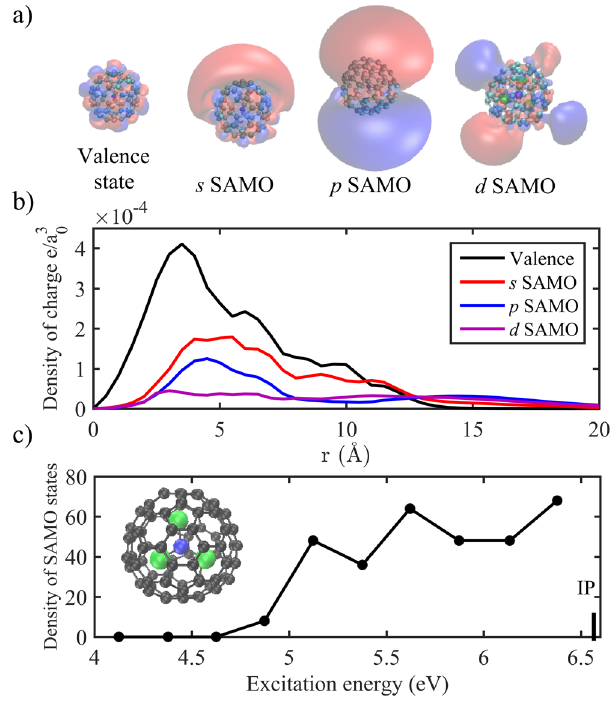
Figure 3. ( a ) Dyson orbitals of a typical valence state, s SAMO, p SAMO and d SAMO states of Ho 3 N@C 80 with an isocontour of 0.002|e|/Å. ( b ) Charge density of the Dyson orbitals of panel a. ( c ) Density of SAMO states as a function of the excitation energy. The electronic states and Dyson orbitals have been computed in TDDFT at the LC-BLYP/6–31G(d) + ECP56MWB/7s6p5d for Ho + Bq (6–31(6 + )G(d)) level for Ho 3 N@C 80 ’s lowest energy isomer shown in the